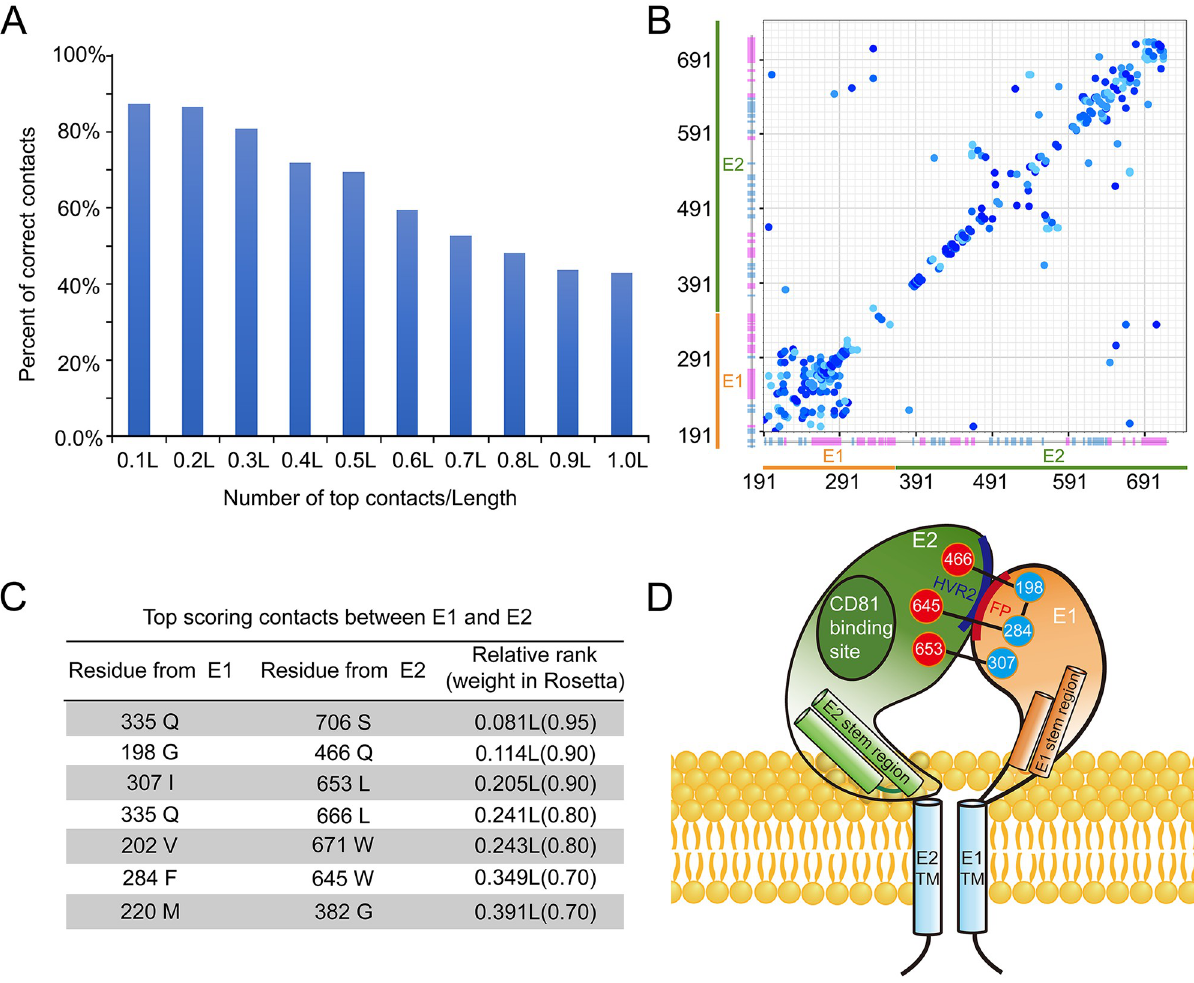
Fig 5. Coevolution based structural modeling of HCV E1E2 heterodimer. (A) Histogram of the accuracy of the top-ranked contacts. The accuracy of the predicated contacts is calibrated using the crystal structures of E2 core. (B) The top 0.5L contacts that are used in the Rosetta modeling protocol are shown as a contact map. Residue numbers of E1 and E2 are labeled and the predicated secondary structures of E1 and E2 are shown as bars with α -helix in magenta and β -sheet in cyan. (C) A table of the predicted top scoring contacts between E1 and E2. (D) A cartoon representation of E1E2 heterodimer on HCV envelope. The residues that may form contacts as well as the locations of the fusion peptide (FP), hyper variable region 2 (HVR2) and the CD81 binding site are shown in the model.